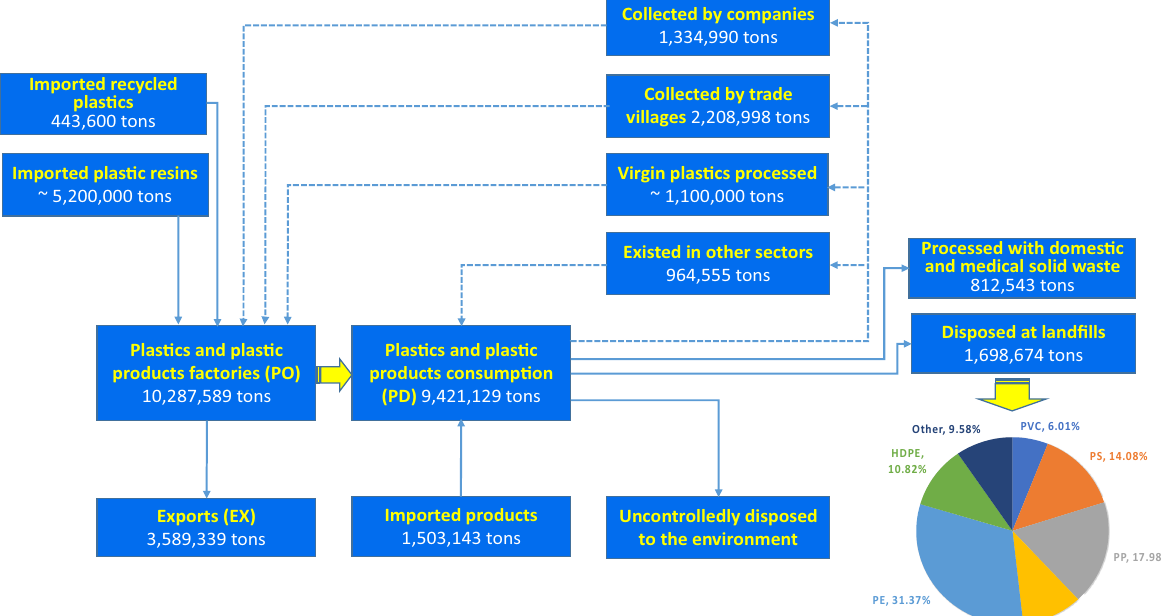
Figure 3: Plastic waste fl ows in